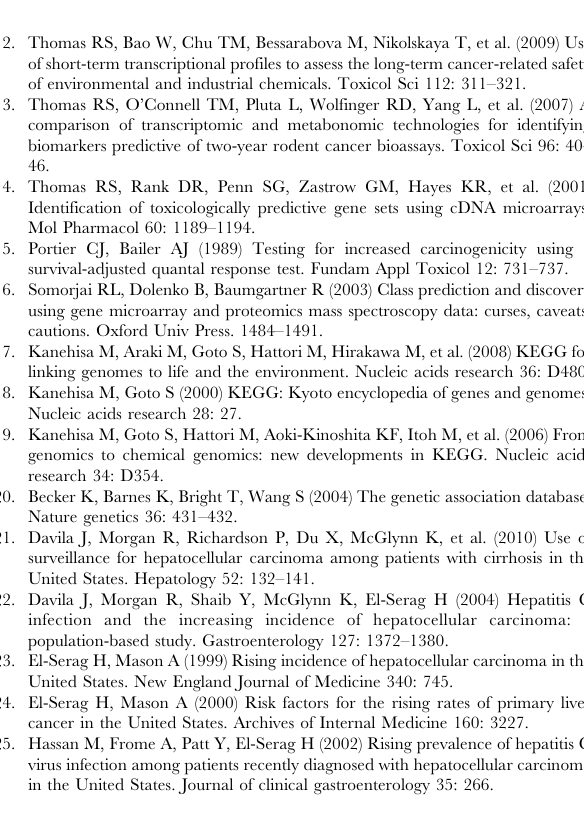
Figure S1 Clustergram of transformed p-values (Equa- tion (1)) representing the enrichment of the 216 path- ways across the 26 chemicals treatments in mice, was generated using hierarchical clustering with the euclid- ean distance metric and average linkage to generate the hierarchical trees of pathways and chemicals using the Cluster and Tree view programs [ 58 ] .